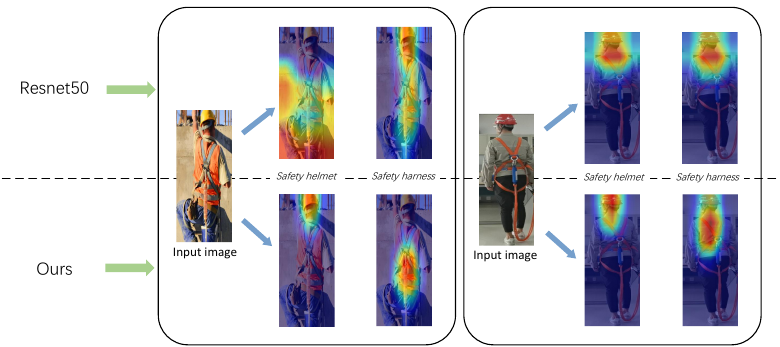
Figure 16. Attention comparison of different models. Visualization of different spatial information extracted by the Resnet50 model (the top part) and our method (the bottom